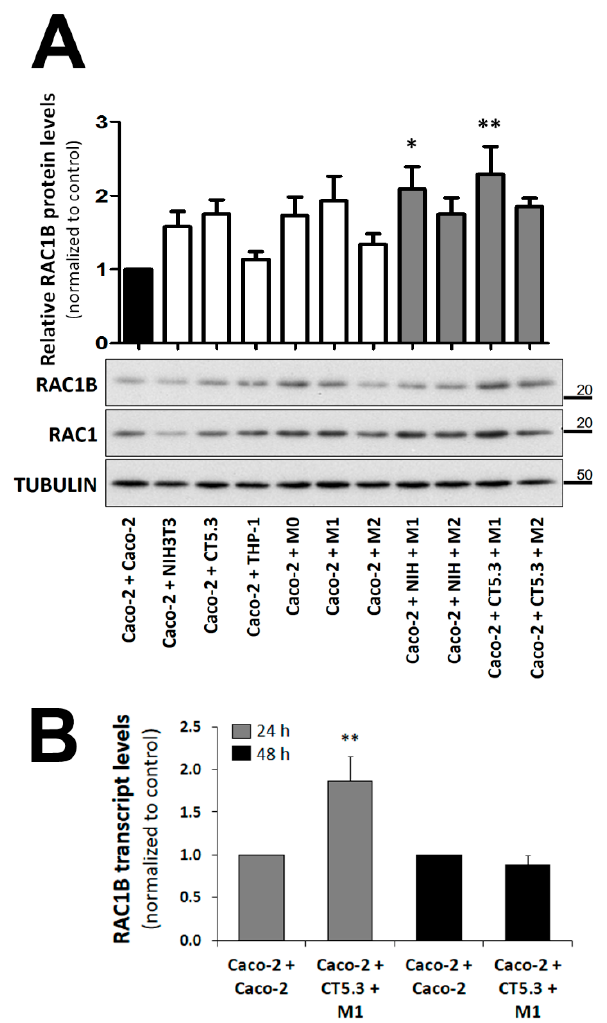
Figure 3. Effect of different co-culture conditions on the RAC1B expression levels in polarized Caco-2 cells. Polarized Caco-2 cells were co-cultured with the indicated control or stromal cells and lysed after 48 h of culture. ( A ) Proteins from the whole-cell lysates were analysed by SDS-PAGE and the indicated proteins detected by WB. The control of the assay corresponds to the co-culture of Caco-2 with Caco-2, and the α -tubulin protein served as a loading control. Migration position of molecular weight markers is indicated in kDa. The corresponding quantification of RAC1B levels in Caco-2 was obtained from at least three independent biological replicate experiments. Band intensities were measured and normalized to tubulin levels. Then, the RAC1B/RAC1 ratio was calculated (as both are derived from the same pre-mRNA transcript). Data are shown as the fold-change in the RAC1B/RAC1 ratio relative to control and represent means ± SEM, of at least 5 independent experiments. Statistical analysis was carried out with a one-way ANOVA test (F = 2.82; p < 0.0056), followed by a Tukey’s post hoc test. * or ** significantly different from the corresponding control (Caco-2 + Caco-2) with p < 0.05 or p < 0.01, respectively. ( B ) Total RNA was extracted from polarized Caco-2 cells after 24 h and 48 h of the indicated co-culture, cDNA synthetized, and RAC1 and RAC1B transcripts amplified by qRT-PCR. Data are shown as fold-change relative to control of the RAC1B/RAC1 ratio (both derive from the same pre-mRNA) and represent mean values ± standard error of the mean (SEM), of 5 independent experiments. Statistical analysis was carried out with a one-way ANOVA test (F = 79.69, p < 0.001), followed by Tukey’s post hoc test; ** significantly different from the corresponding control with p <